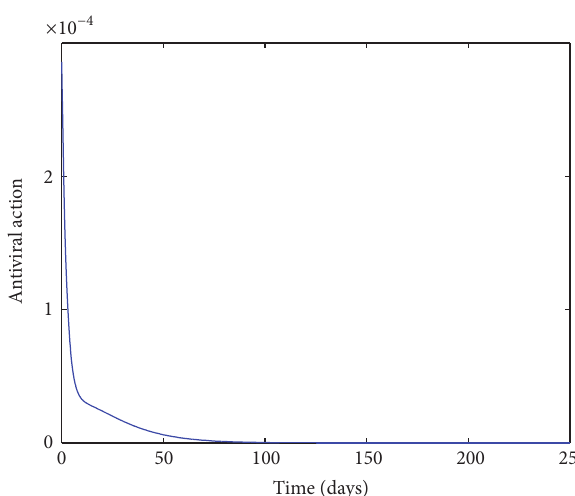
Figure 22: Vaccination function 𝑉 = 0.2𝑏 1 + 0.002𝑆(𝑡) when a daily culling rate of 𝜌 𝐷 = 0.1 and antiviral treatment 𝜉(𝑡) = 𝐾 𝜉 𝐼(𝑡) = 0.01𝐼(𝑡) are applied.